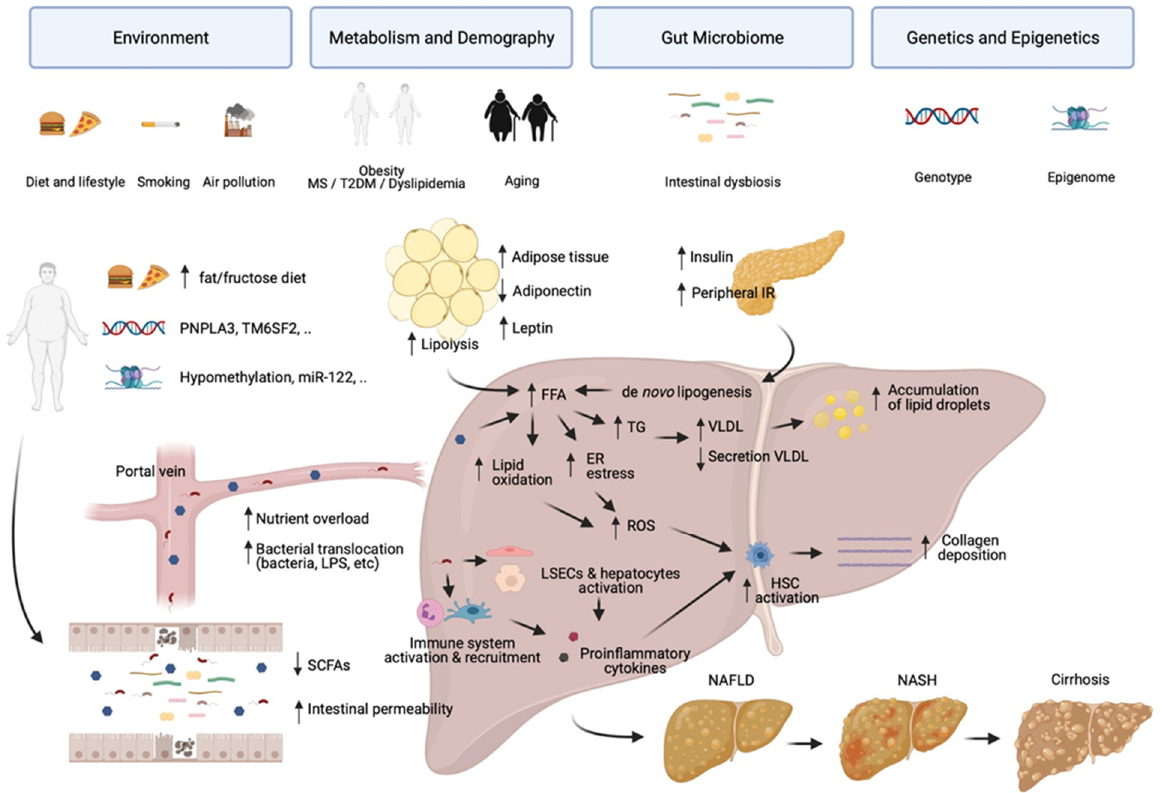
Figure 1. Major risk factors and pathophysiology of NAFLD. Genetically susceptible individuals under adverse environmental conditions including smoking, air pollution, and/or poor diet enriched in fat/fructose are prone to developing NAFLD. Obesity, MS, T2DM, dyslipidemia, and age increase the risk for fatty liver disease. Increased energy uptake due to high fat diet leads to an increased body fat, peripheral tissue insulin resistance, and metabolic syndrome. Augmented lipolysis, de novo lipogenesis, and constant absorption of high-energy nutrients induce increased FFAs and ultimately hepatic steatosis. Lipotoxicity, due to increased levels of lipids in the liver, induce production of ROS due to increased lipid oxidation and ER stress. Poor diet in vulnerable patients may induce intestinal dysbiosis associated with reduced production of SCFAs and increased intestinal permeability. Bacterial translocation of bacteria or its products to the liver result in activation of immune cells, hepatocytes, and LSECs, and release of proinflammatory cytokines. Production of ROS and proinflammatory cytokines drive the activation of HSCs and deposition of collagen inducing fibrosis and progression of liver disease from simple steatosis to steatohepatitis, cirrhosis and hepatocellular carcinoma. MS: Metabolic syndrome; T2DM—Type 2 diabetes mellitus; SCFAs—Short-chain fatty acids; FFA—Free fatty acids; TG—Triglyceride; VLDL—Very low-density lipoprotein; ER—Endothelial reticulum; ROS—Reactive oxygen species; LSECs—Liver sinusoidal endothelial cells; HSC—Hepatic stellate cells; NAFLD—Non-alcoholic fatty liver disease; NASH—Non-alcoholic steatohepatitis. This figure was created using the BioRender platform.